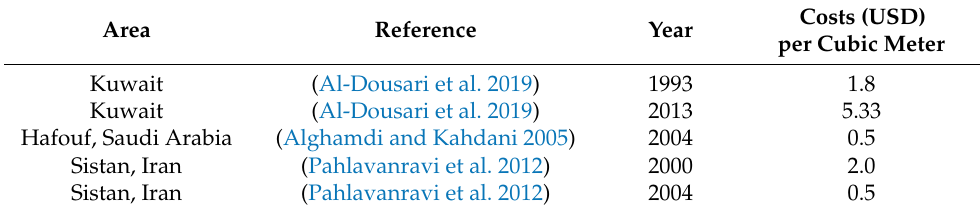
Table 6. Costs of removal of blown sand from infrastructure in the Middle East in selected